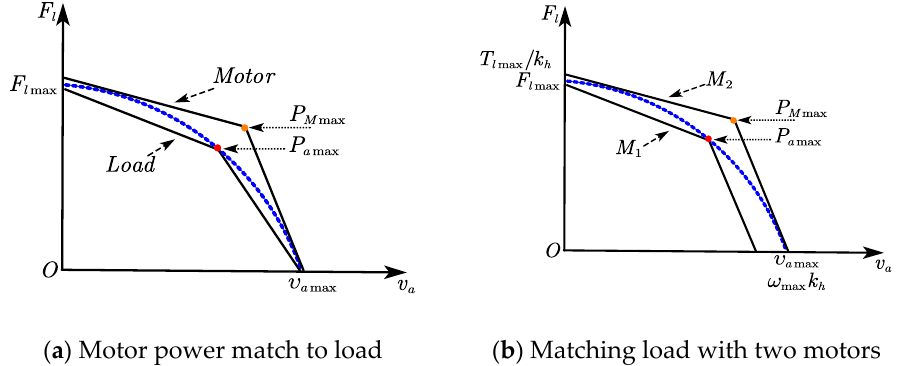
Figure 13. Actuator power requirement and motor power output curves.